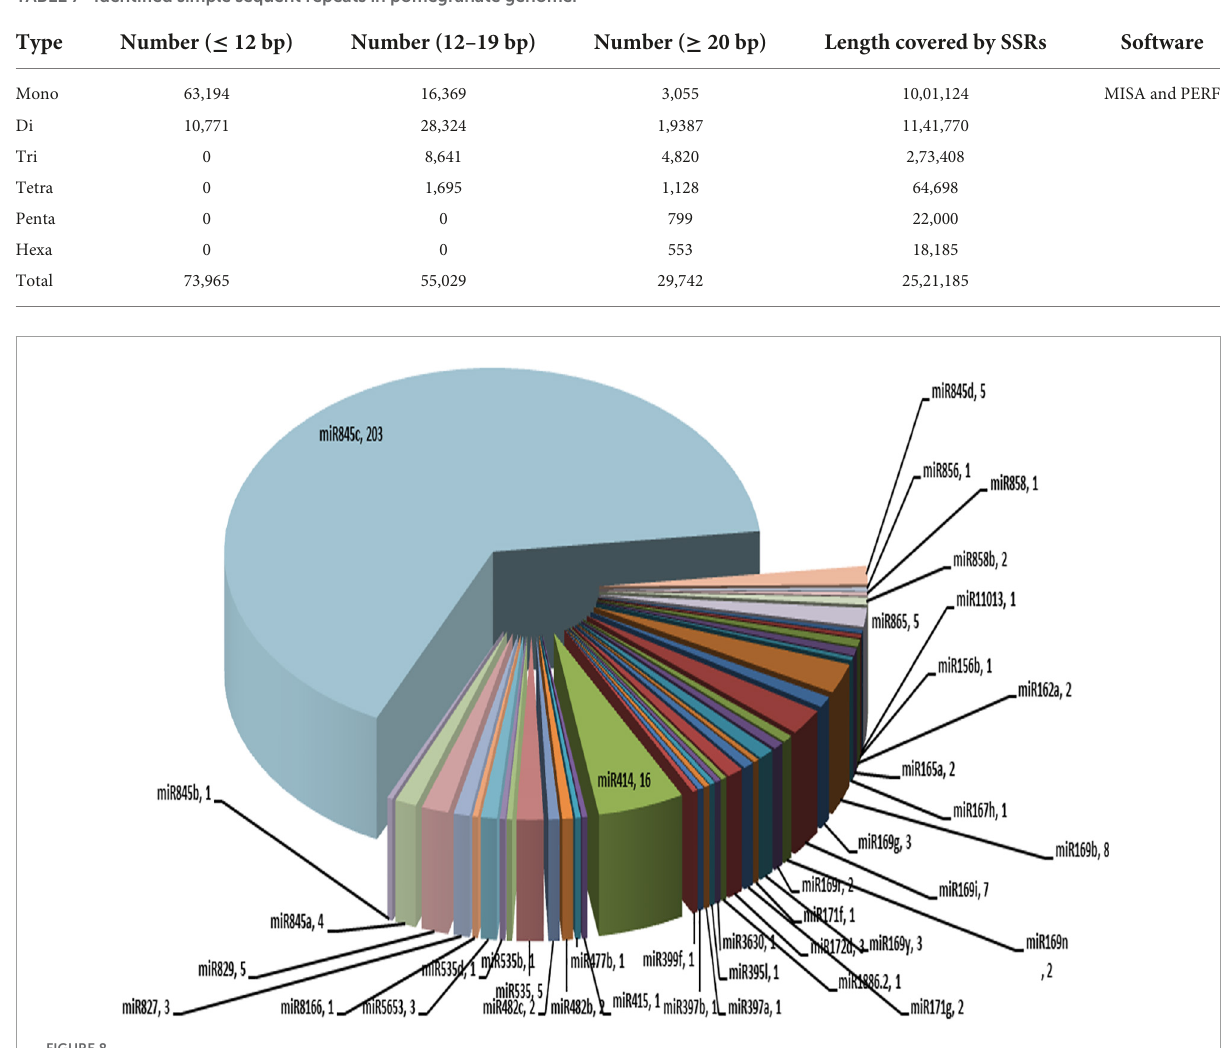
FIGURE8 MicroRNAs representing 26 different families identified in the ‘Bhagawa’